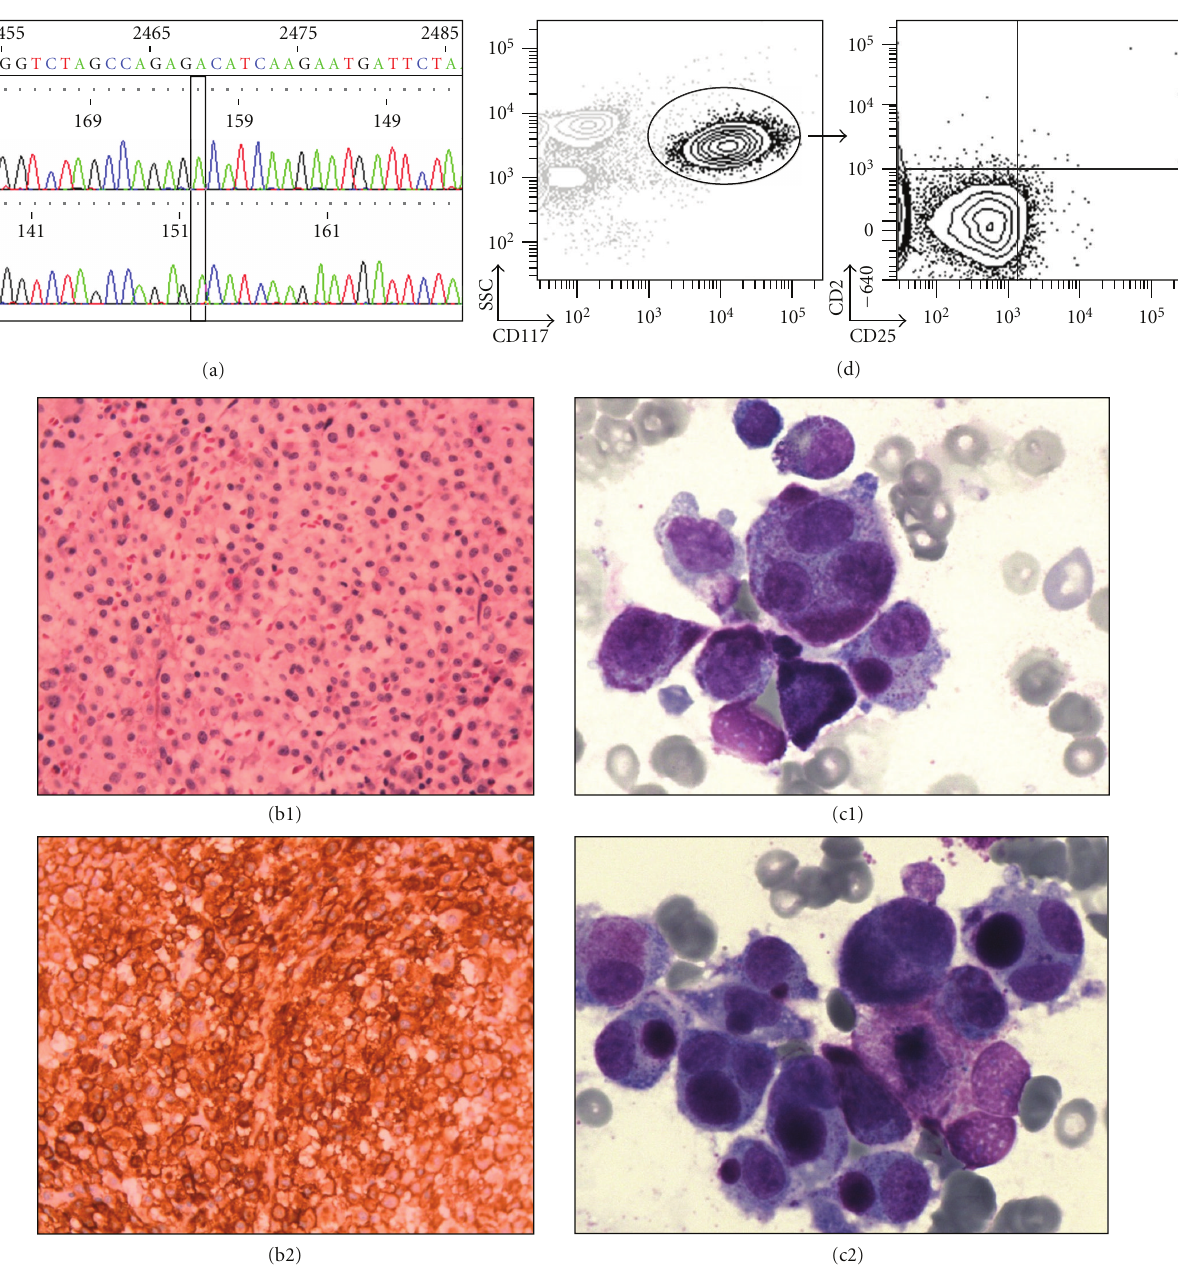
Figure 1: Main features of our patient. (a) Shows the results of a complete c-KIT sequencing: absence c-KIT mutation, especially in exon 17. Indeed, the patient harbored no c-KIT mutation on any exon. (b) shows the results of bone marrow biopsy. (b1): Coloration HES, × 400; (b2) c-KIT immunostaining, × 400. Bone marrow aspirates showed in (c1) a mixture of normal mast cell, leukemic round mast cells, and two very atypical nucleated mast cells with loose chromatin, representing more than 30% of nucleated marrow cell. (c2): cluster of atypical mast cells with a round basophilic mass in the cytoplasm. (d): Immunophenotypic profile of mast-cells characterized by strong KIT/CD117 CD2 and CD25